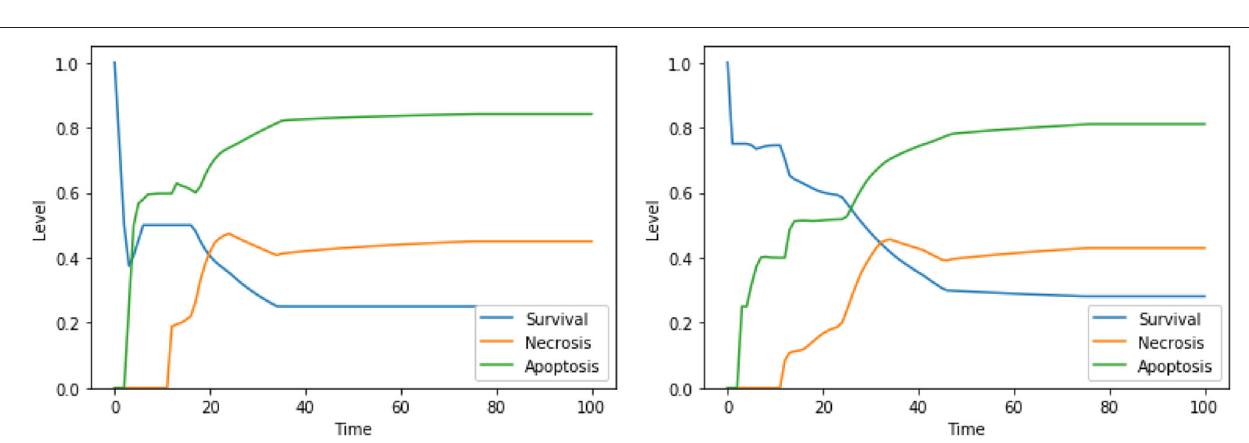
FIGURE 8 | Simulation of the DFM in the PKA low condition, using the perturbations “DeltaPsi IS low, ERK IS low, UPR IS high” (left) and “Ca 2 + IS high, ERK IS low, UPR IS high” (right)